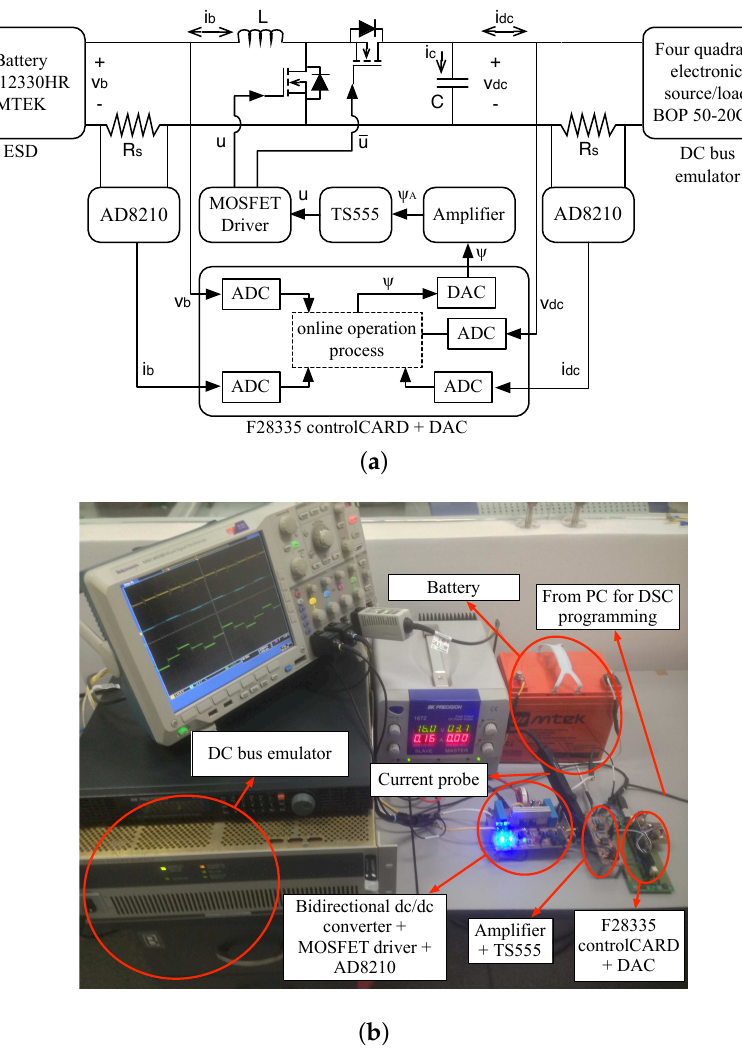
Figure 19. Experimental platform. ( a ) Schematic diagram of the experimental platform; ( b ) Experimental